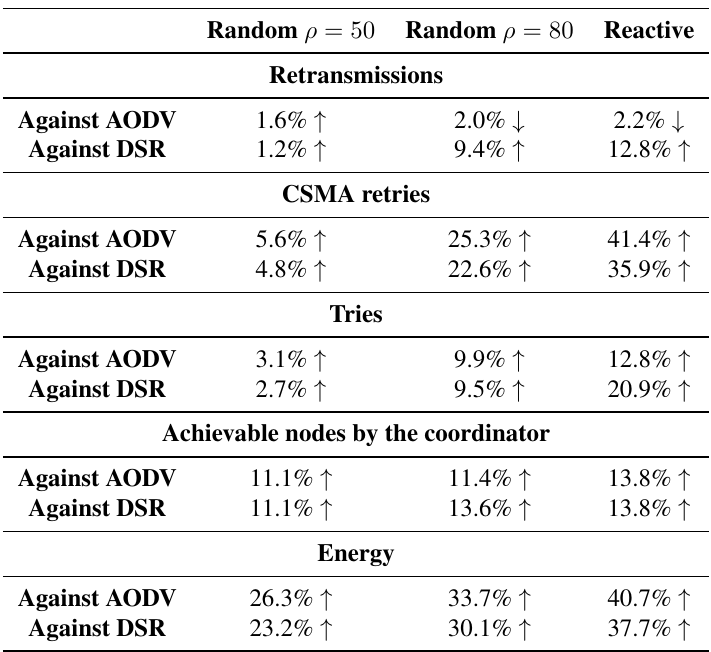
Table 10 reflects the impact of different attack strategies on the routing performance. The metrics studied throughout this work show the performance of each routing protocol (AODV, DSR and